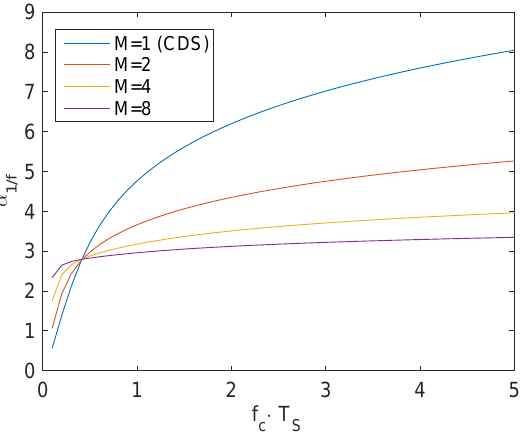
Figure 6. Numerical calculation of the parameter α 1/ f from Equation (6) as a function of the ratio between the cutoff frequency of the readout chain and the sampling frequency of the correlated sampling T f c · T S for a simple CDS and CMS with different orders M